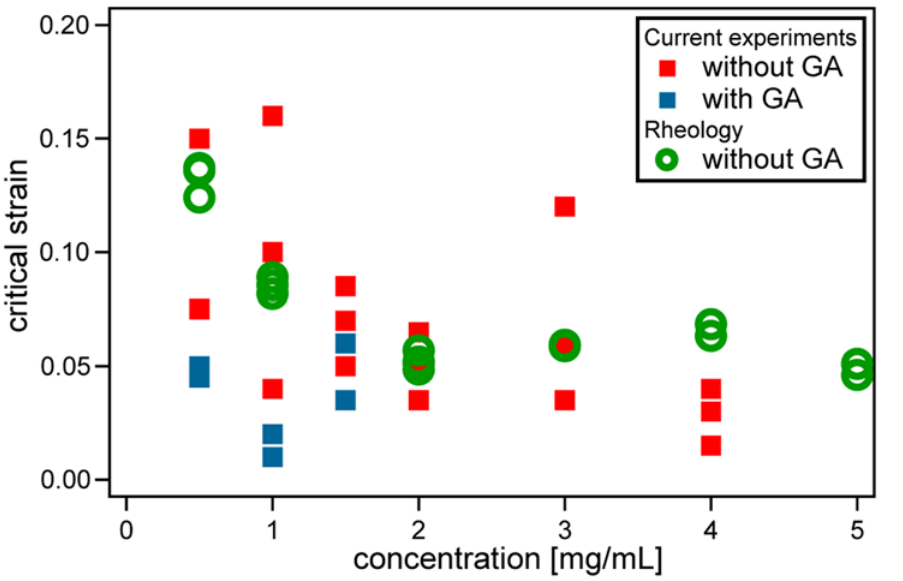
Figure 6. Comparison of critical strains measured from bulk rheology and 2-point stretching. Comparison of critical strain measured from the PIV method ( e crit such that dA e crit ð Þ = d e xx ~ 0 , see Results) on locally stretched samples with the onset of strain stiffening ( c crit such that s w 1 : 1 G ’ 0 c , see Results) obtained from rheological